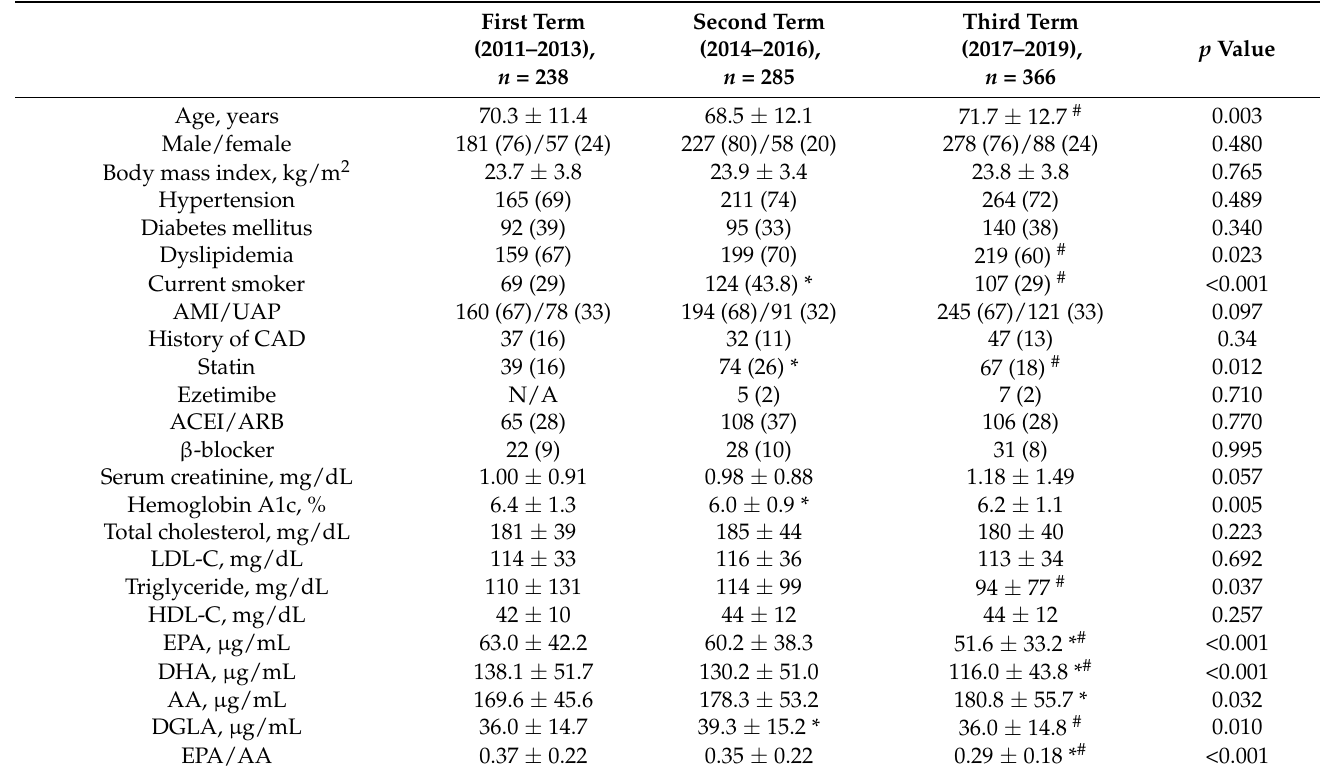
Table 1. Patient characteristics in the first, second and third